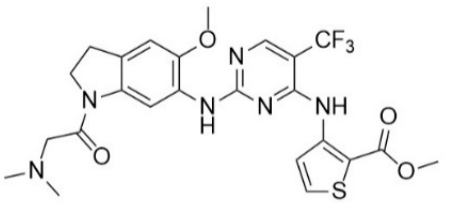
Figure 2. Chemical structure of Compound 17 (The most active compound used in our study).